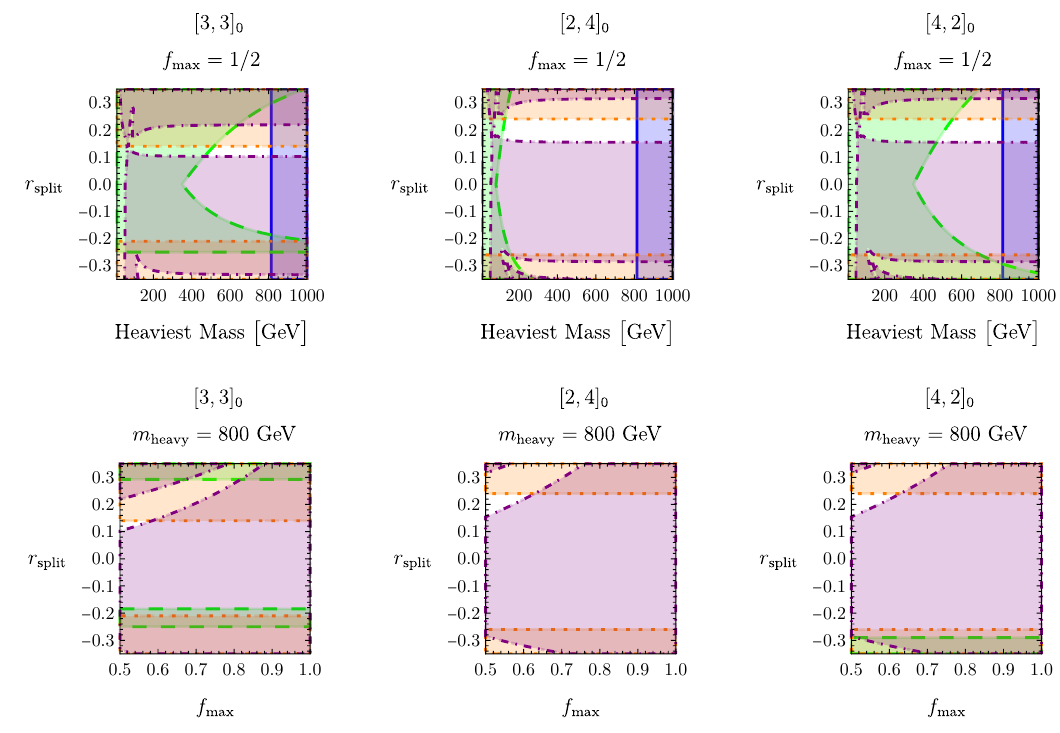
Figure 9 . Regions of parameter space for scalar Loryons which are ruled out by one of the constraints described earlier. The orange, dotted region is ruled out by the electroweak precision parameter S ; the purple, dot-dashed region is ruled out by constraints on κ ; the blue, solid region γ is ruled out by unitarity bounds; the green, dashed region is ruled out by direct search bounds. The first row has fixed f = . 5 ; the second row has fixed the heaviest mass eigenvalue at 800 max